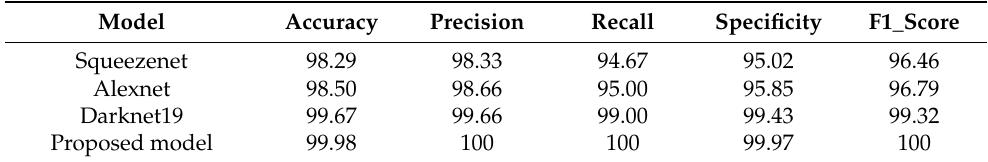
Table 13. COVID-19 three-class classification using chest radiographs comparison with state-of-the- art